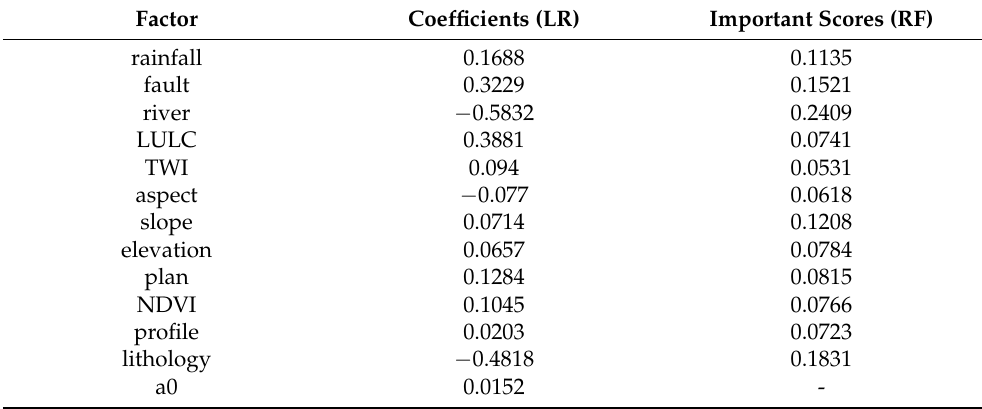
Table 5. List of coefficients (LR) and important scores (RF).